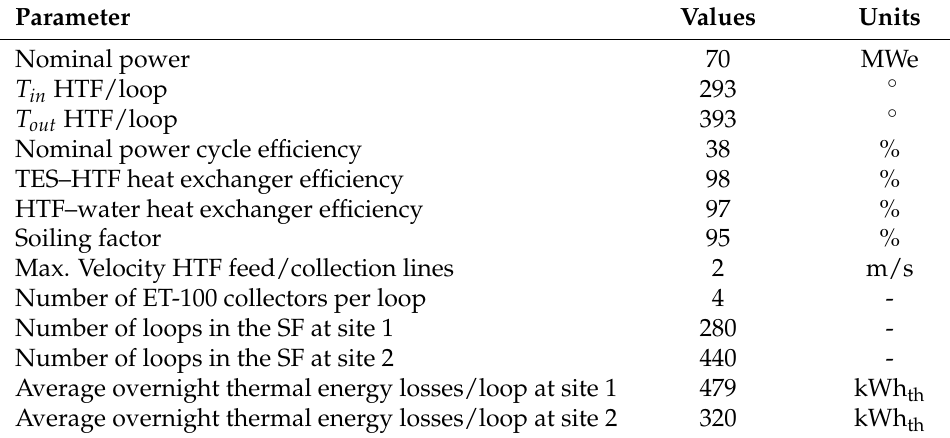
Table 6. Main plant design parameters